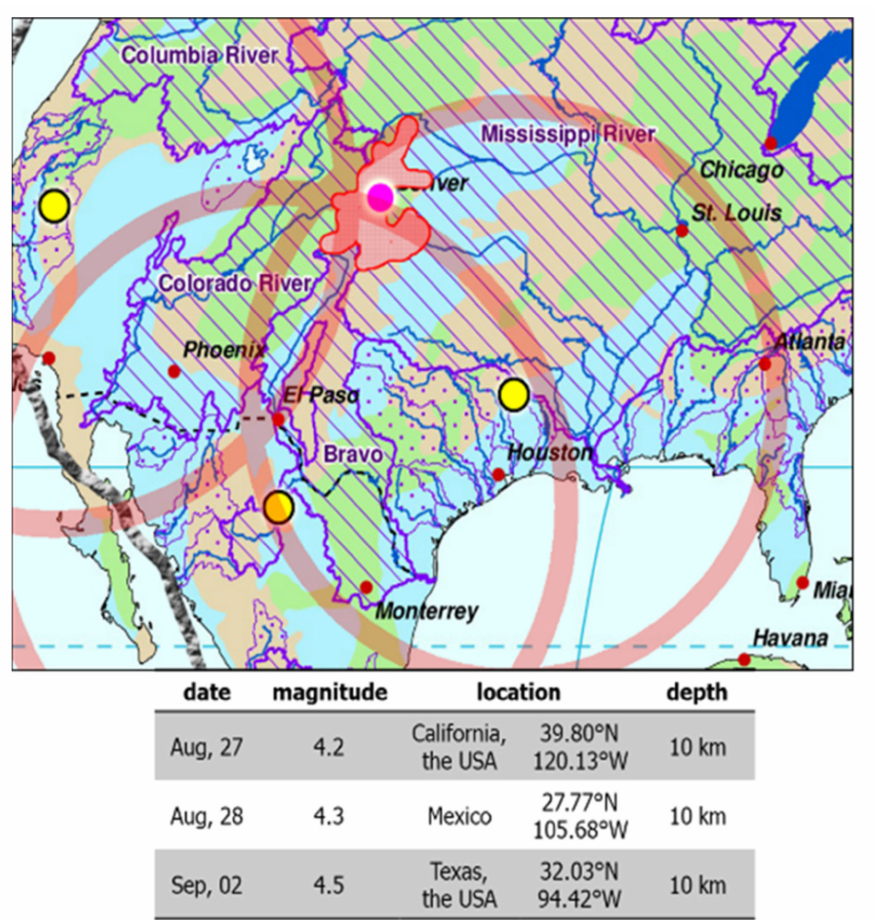
Figure 17. The Boulder County (Colorado, USA, purple circle on the map) event, located exactly where three wave circles cross, with centers in the earthquakes’ epicenters (yellow circles on the map); i.e., this region has experienced a great conflict of seismic